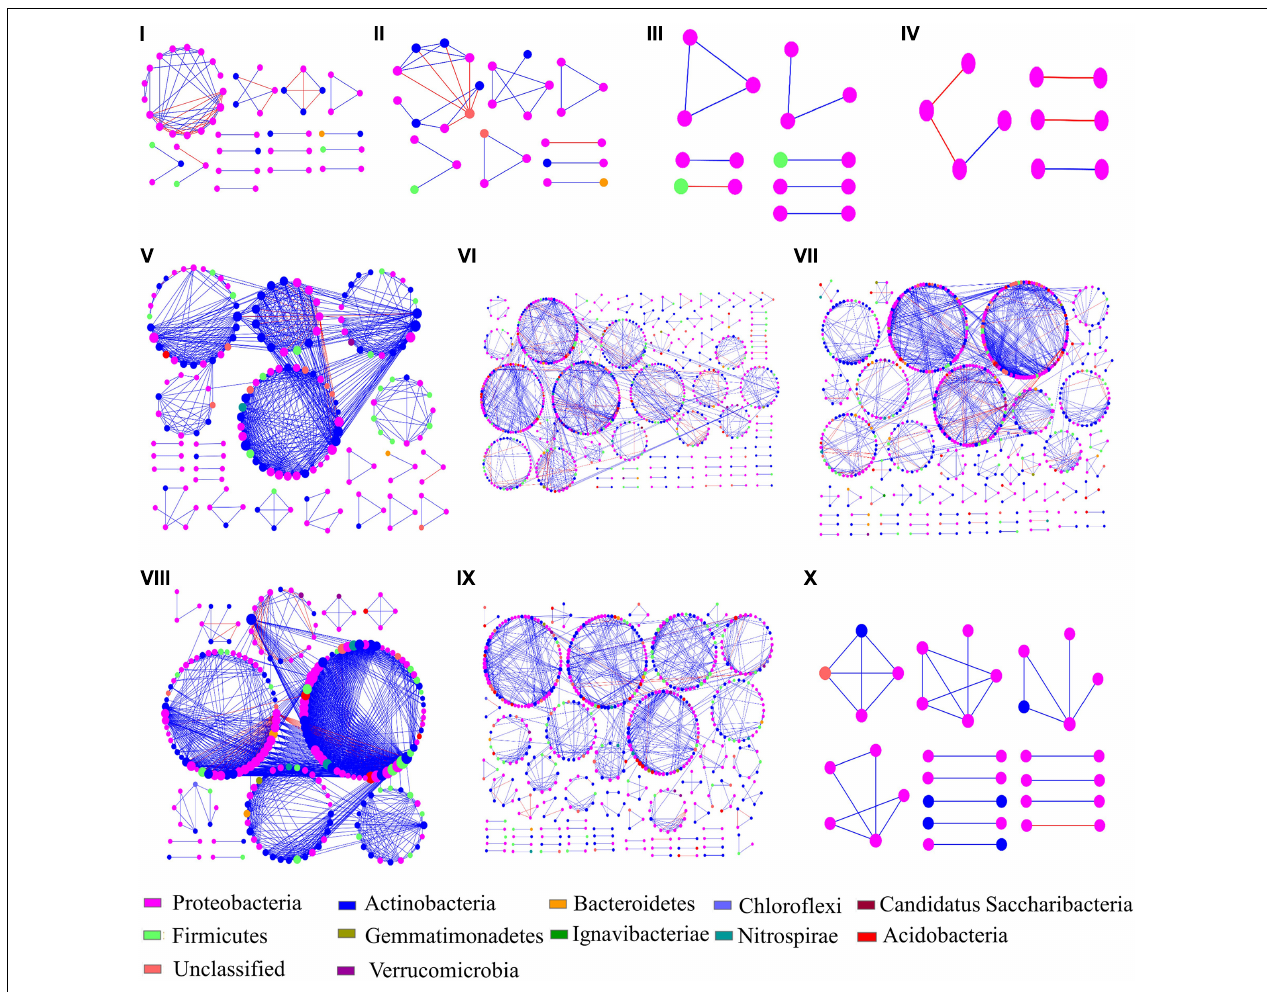
FIGURE 4 | Bacterial endophyte interaction networks of ten rice cultivars. The different sections (I–X) represent the cultivars (I–VIII,IX,X) , respectively. The node colors represent different phyla and the node size represent the number of links with other nodes. Blue and red links indicate positive and negative interactions,